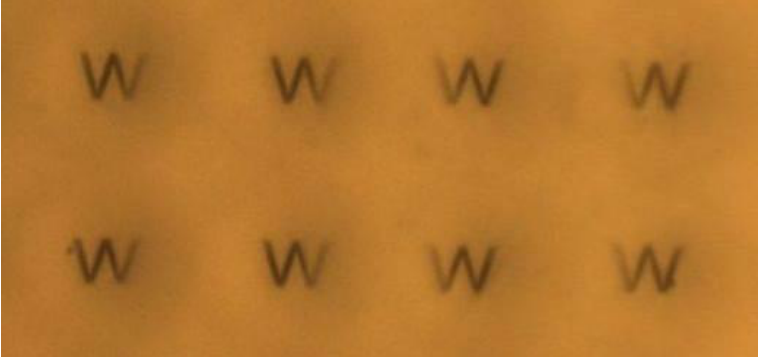
Figure 6. Image of an array of inverted “W”s imaged through a 2 × 4 microlens array. The eight inverted images are clear and sharp which shows good uniformity among the neighboring